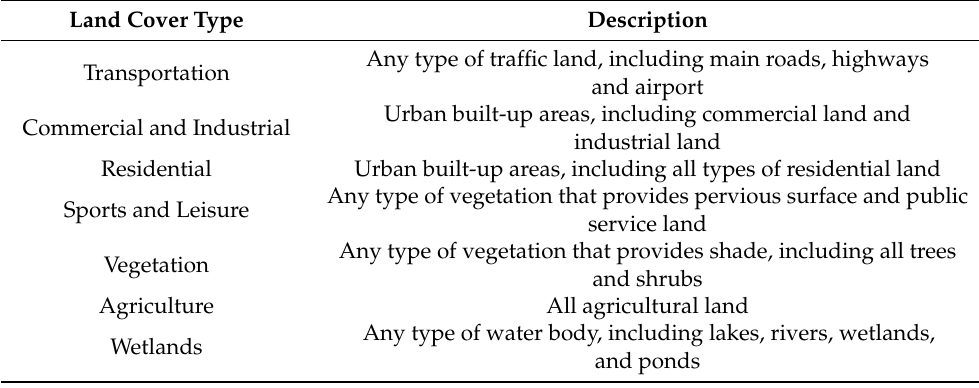
Figure 3. The conceptual framework to investigate statistical relationships between LUCP indices and LST characteristics.